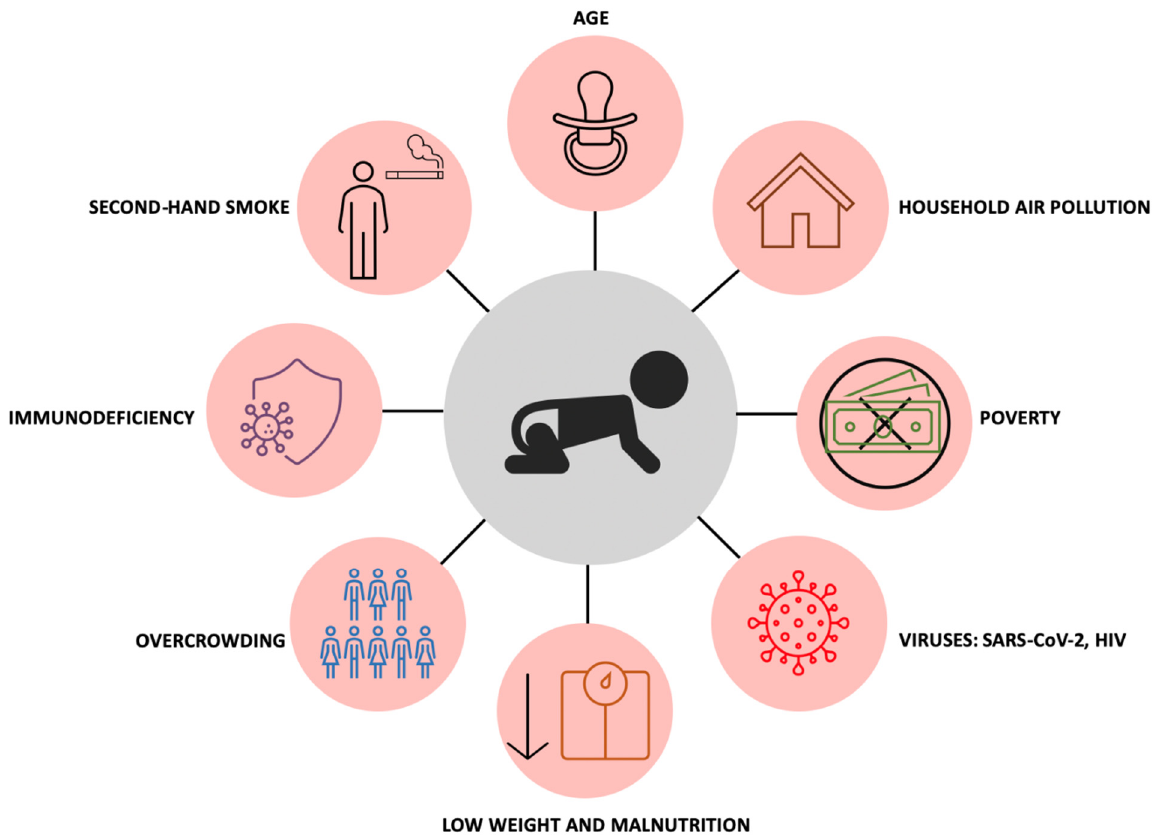
Figure 2. The likelihood of acquiring childhood TB is impacted by age, where infants and children below 5 years have the greatest risk, household air pollution, poverty, SARS-CoV-2 and HIV infection, low weight and malnutrition, overcrowding, immunodeficiency, and second-hand smoke ex- posure.